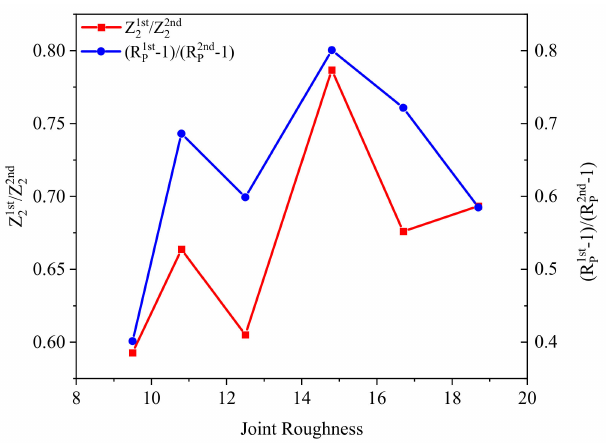
Figure 16. Statistical parameter ratio of waviness and